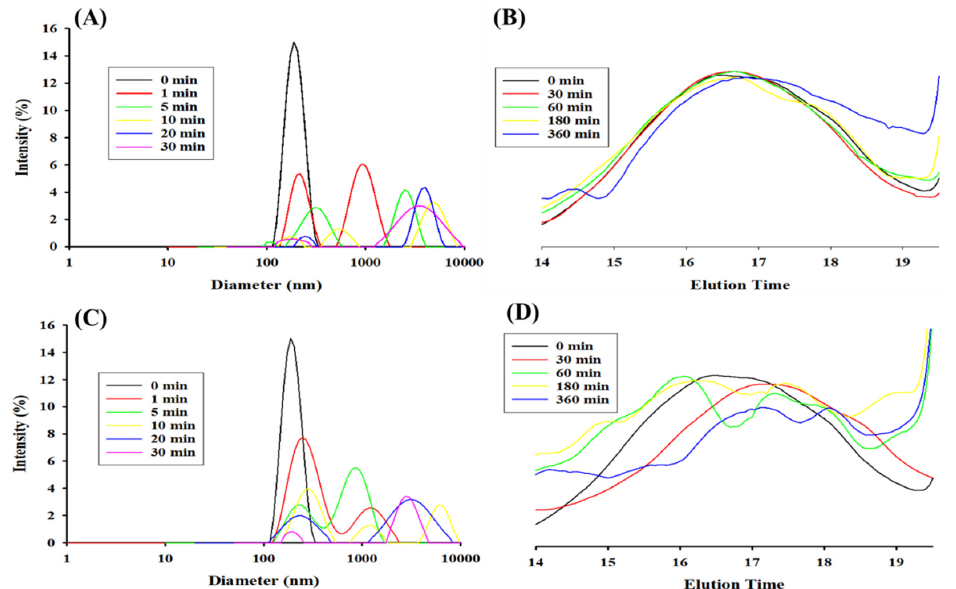
Figure 2. Dynamic light scattering (DLS) ( A , C ) and size exclusion chromatography (SEC) ( B , D ) profiles of MCP 50 ( A , B ) and MSP 50 ( C , D ) treated with 5 mM glutathione (GSH) for different durations.